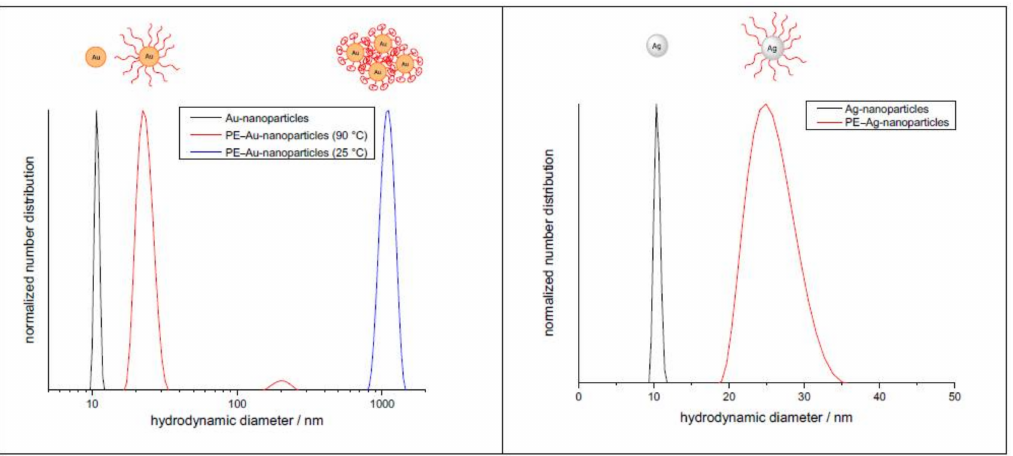
Figure 1. Number distributions from dynamic light scattering measurements of unfunctionalized and polyethylene-functionalized gold- and silver-nanoparticles. All samples were recorded in toluene at different temperatures and normalized to the peak